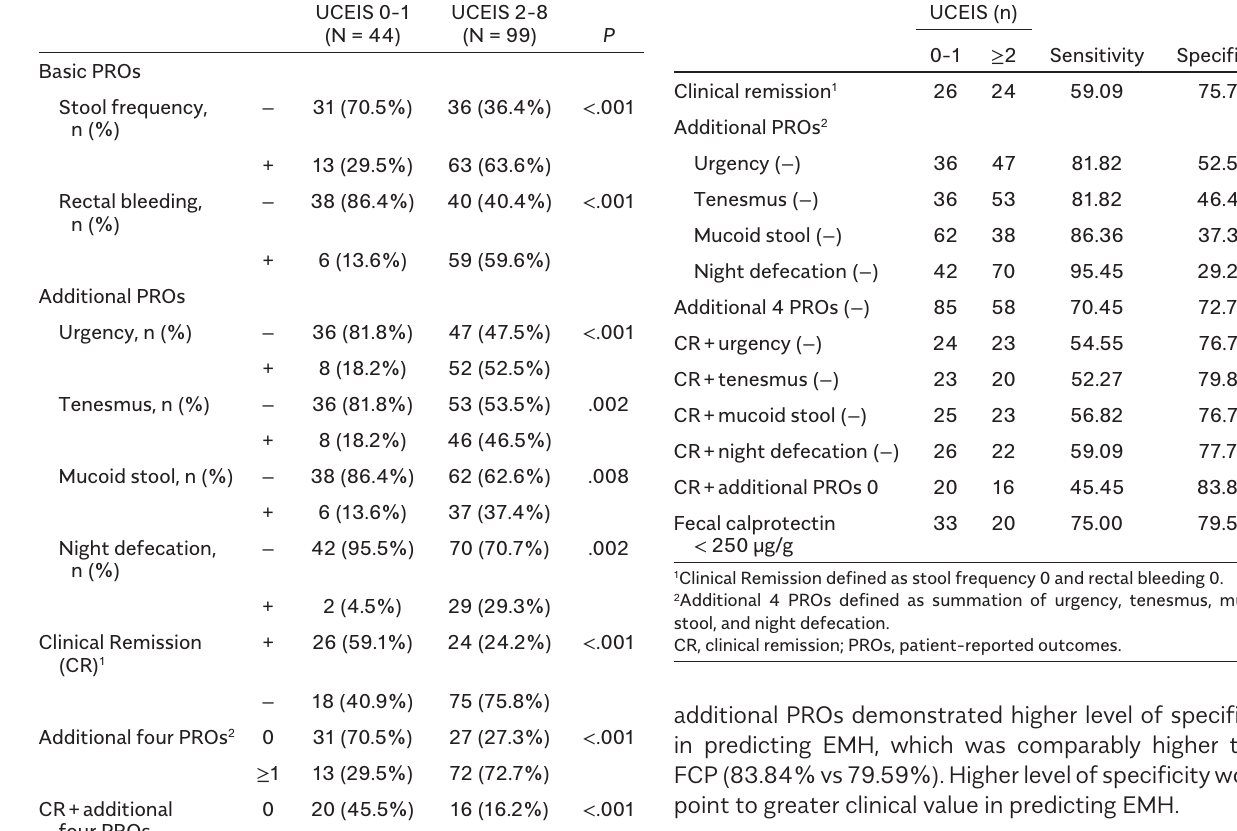
Table 3. Prediction of Endoscopic Mucosal Healing by Basic and Additional Patient-Reported Symptoms and Laboratory